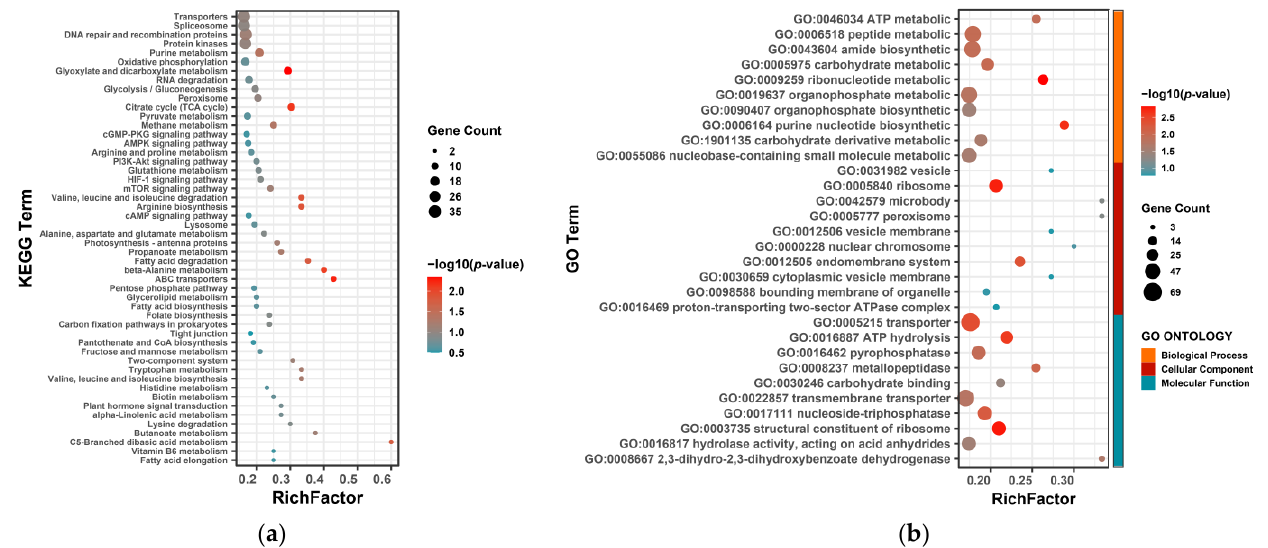
Figure 4. Functional analysis result. ( a ) KEGG enrichment result, which showed the top 50 terms of results; ( b ) GO enrichment, which shows the top 10 terms for each GO ontology.